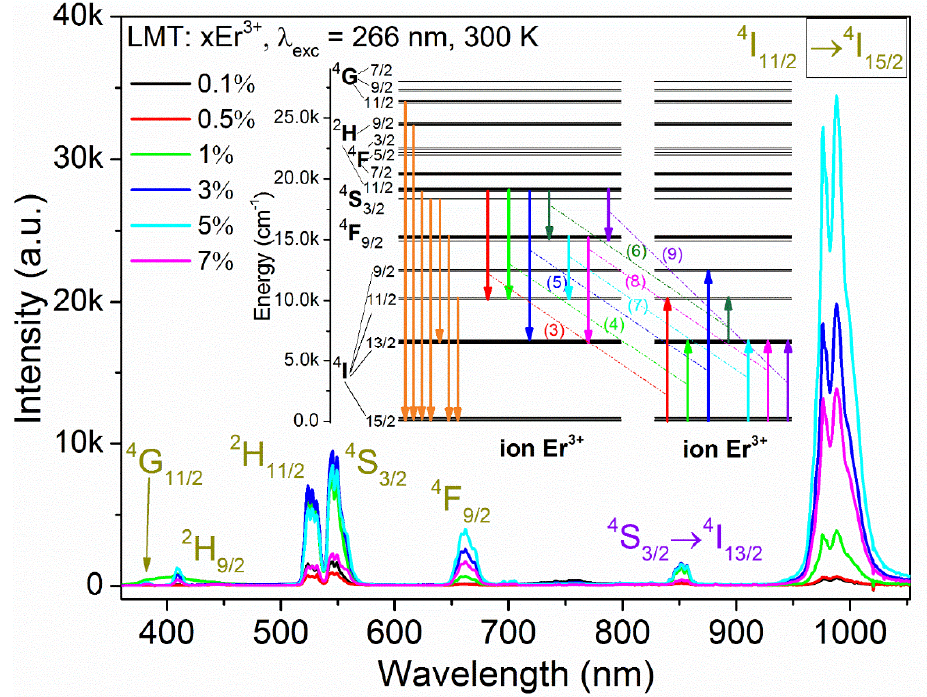
Figure 6. The 300 K emission spectra of La 2 MgTiO 6 :xEr 3+ (x = 0.1%, 0.5%, 1%, 3%, 5%, or 7%) recorded under a 266 nm excitation Nd:YAG line. Inset: Some possible cross-relaxation processes in La 2 MgTiO 6 :Er 3+ .